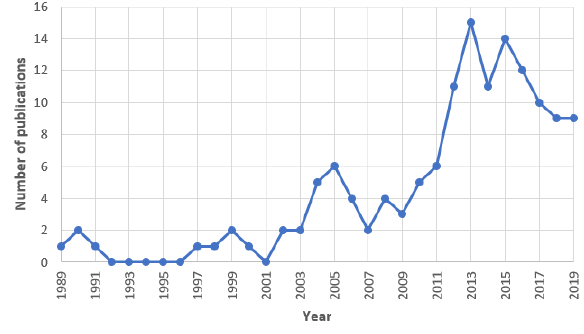
Figure 2. Number of publications per